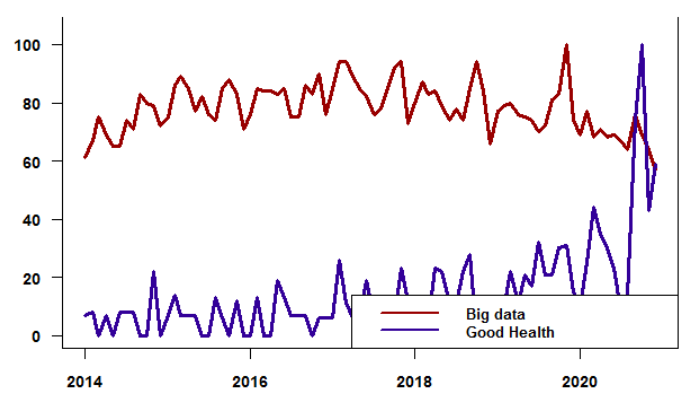
Figure 4. Big Data and SDG 3 global Google trends since 2014.